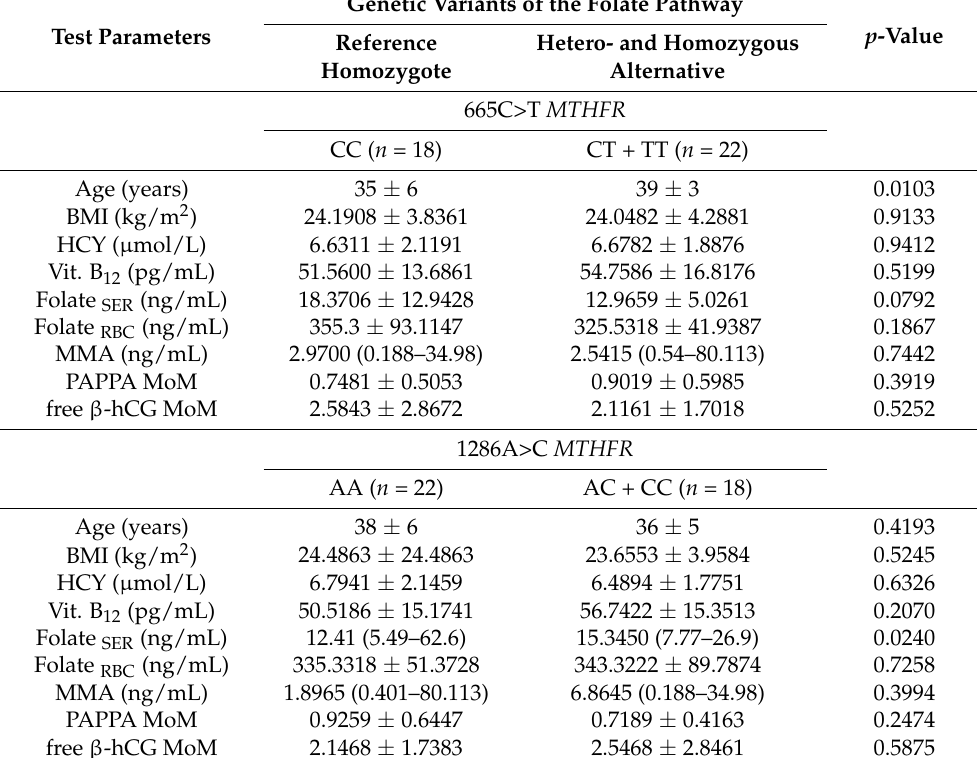
Table 3. Analysis of the changes in the clinical and biochemical parameters depending on the presence of reference homozygous genotypes, as well as heterozygous and heterozygous genotypes of the studied variants of the genes of the folate